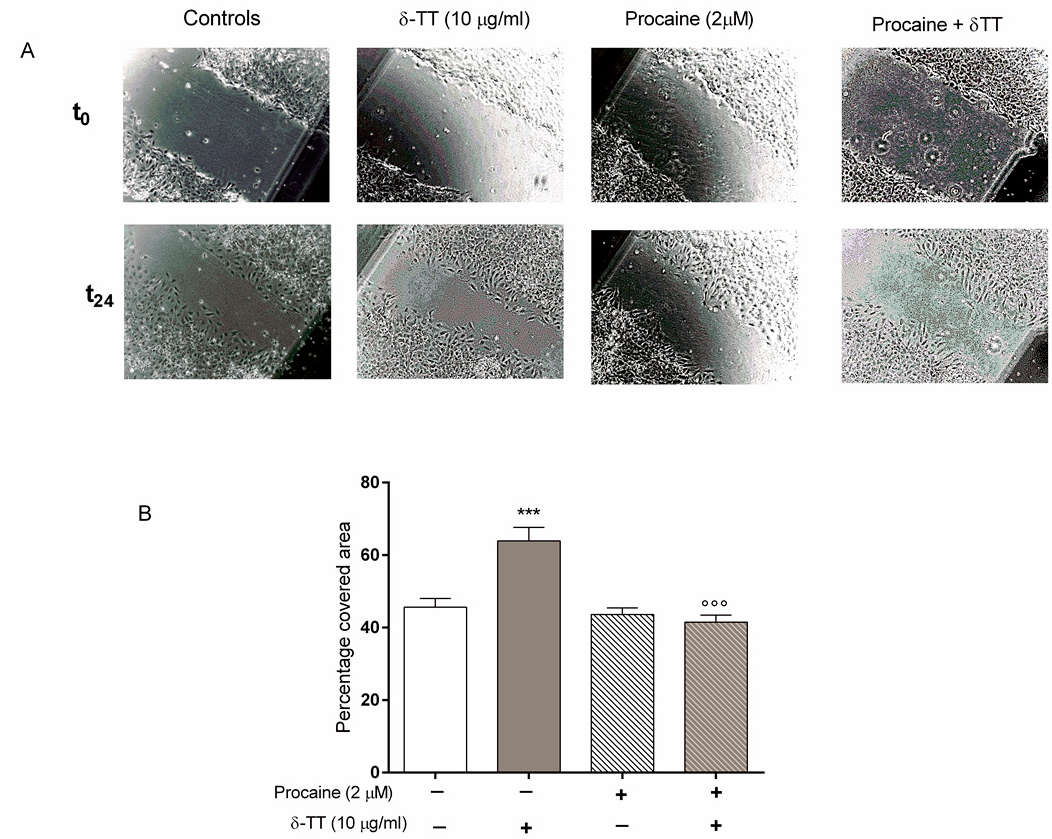
Figure 7. Procaine, a Wnt / β -catenin signalling pathway inhibitor, removed the wound healing e ff ects of δ -TT (10 µ g / mL) in MC3T3-E1 cells. Cells were incubated with procaine (2 µ M) 30 min before δ -TT. The Wound healing assay was performed as detailed in Figure 2. ( A ) Wound healing assay of untreated and treated MC3T3-E1 cells; ( B ) Quantification of wound closure. Data are presented as the mean ± SEM of eight replicates. *** p < 0.001 vs. controls; ◦◦◦ p < 0.001 vs. δ -TT.